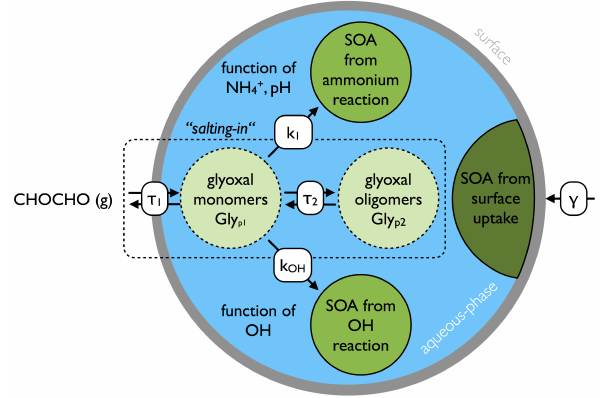
Figure 3. Schematic of pathways that can lead to SOA formation from glyoxal. γ is the uptake coefficient of the surface reaction. k I the rate constant of the ammonium-catalyzed reaction, k OH the one for the OH reaction. τ 1 and τ 2 are the characteristic time scales to fill the monomer/oligomer pool (Gly p1 and Gly p2 respectively, as defined in Kampf et al., 2013). SOA in monomer and oligomer reservoirs is reversible. SOA in surface uptake, and ammonium and OH reaction reservoirs is